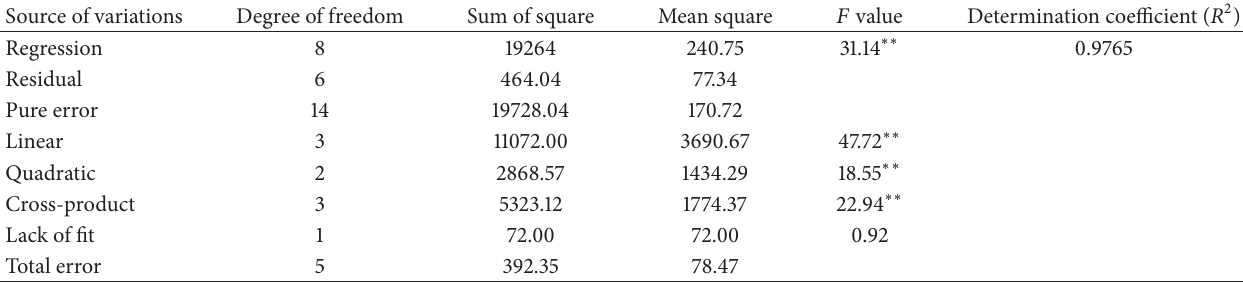
Table 4: Analysis of variance in the regression model for optimisation of glucose production from OPEFB cellulose.